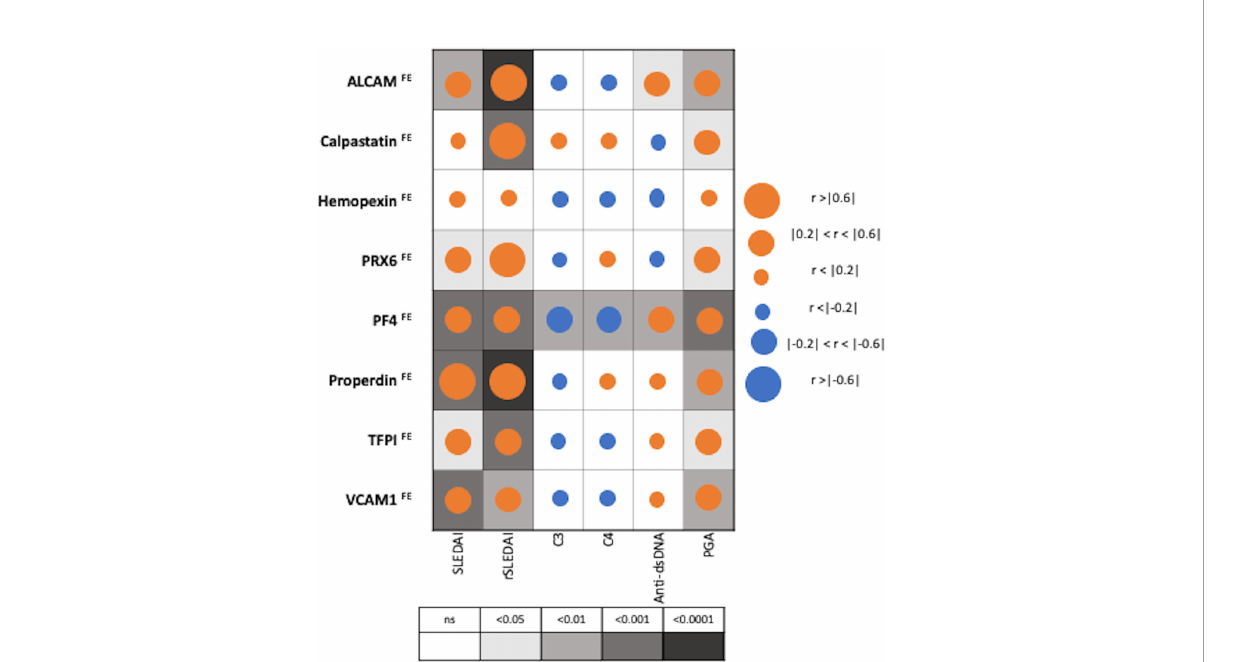
FIGURE 4 Correlation of Fractional Excretion (FE) ratios of eight protein biomarkers with conventional disease activity measures in SLE. The derived FE ratios of the eight interrogated biomarkers were examined for their correlation with SLEDAI, renal-SLEDAI, C3, C4, anti-dsDNA and Physician Global Assessment (PGA) values. Positive and negative correlations are denoted by orange and blue circles respectively, while statistical signi fi cance is denoted using grey-scale boxes. Overall, the urine biomarker fractional excretion ratios correlate best with renal-SLEDAI in